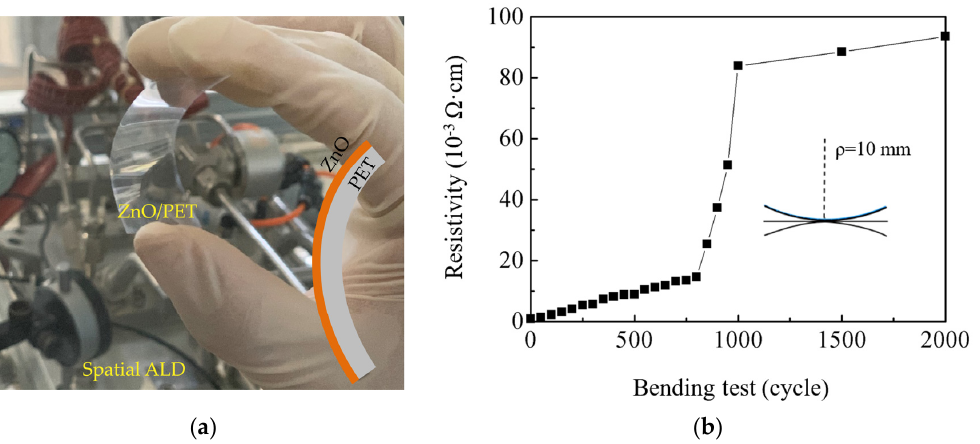
Figure 8. ( a ) A photograph of a bent ZnO/PET sample; ( b ) the bending test results.